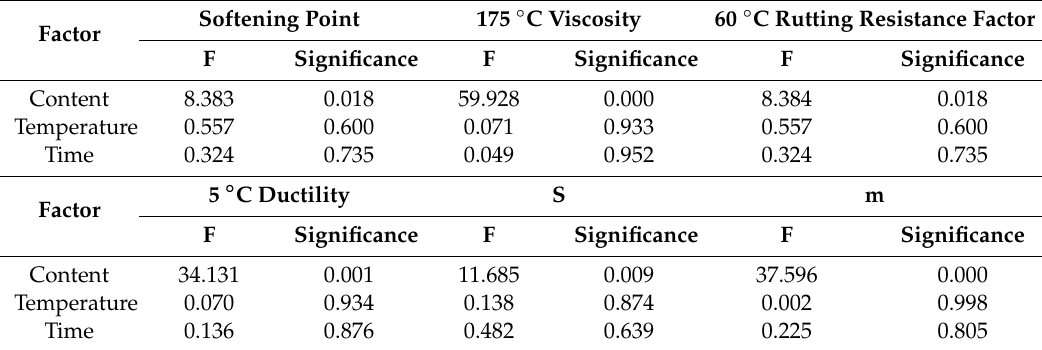
Table 7. Results of variance analysis ( α =